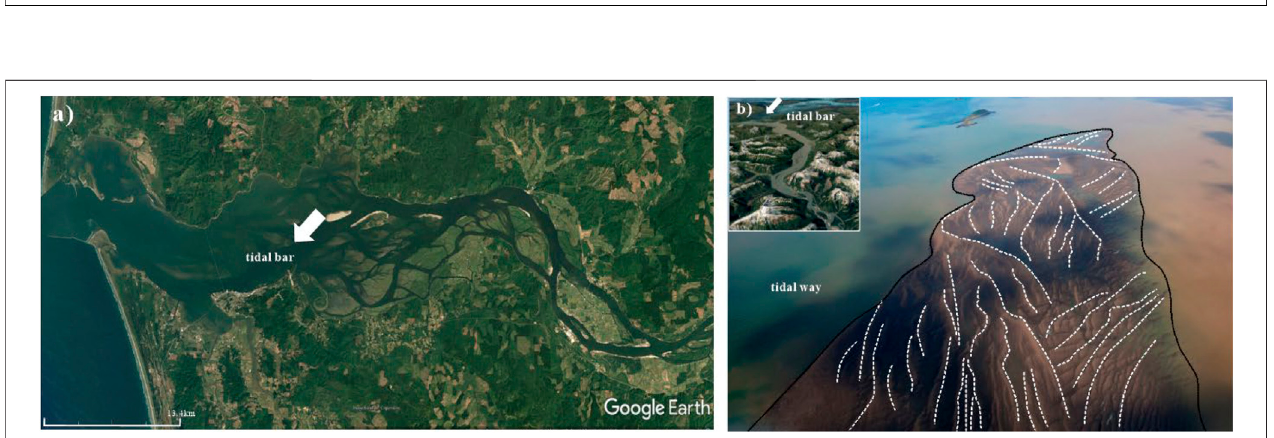
Frontiers in Earth Science |